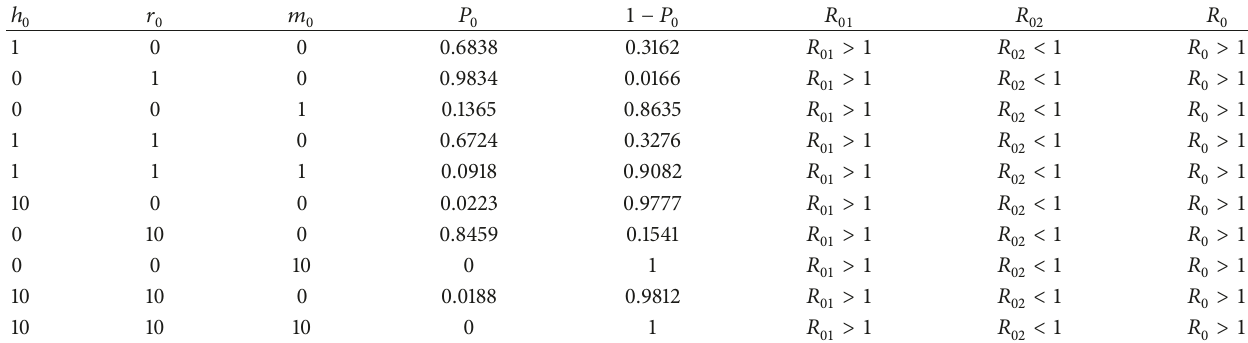
Table 3: Probability of disease extinction 𝑃 0 and of an outbreak 1 − 𝑃 0 for the malaria